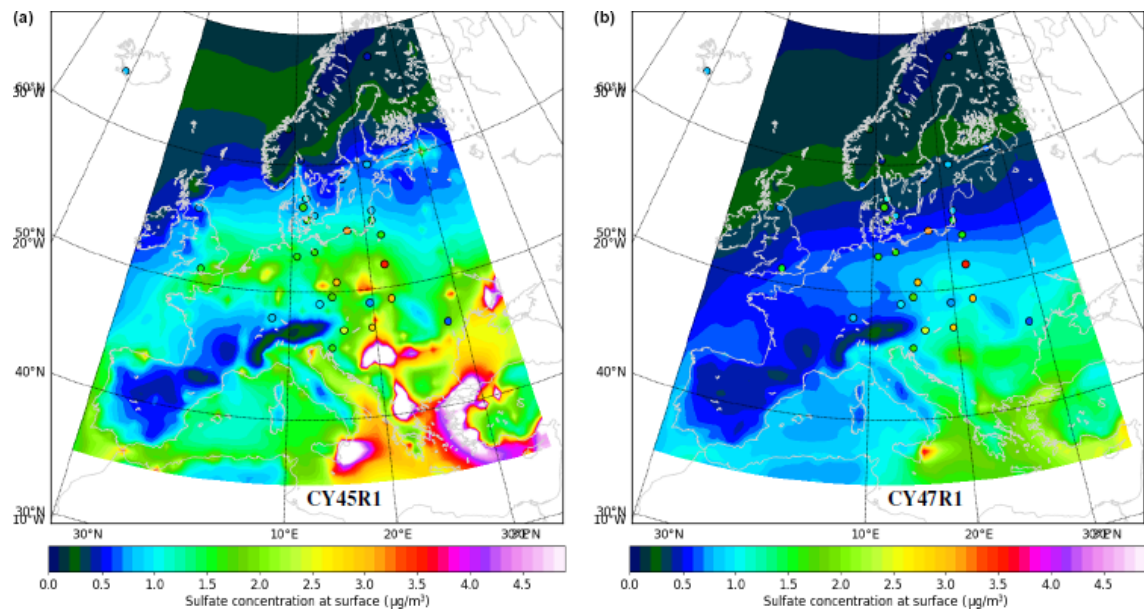
Figure 16. Mean 2017 surface sulfate concentration (in µgm − 3 ) simulated by CY45R1 (a) and CY47R1 (b) against yearly average from the EMEP network (shown as black